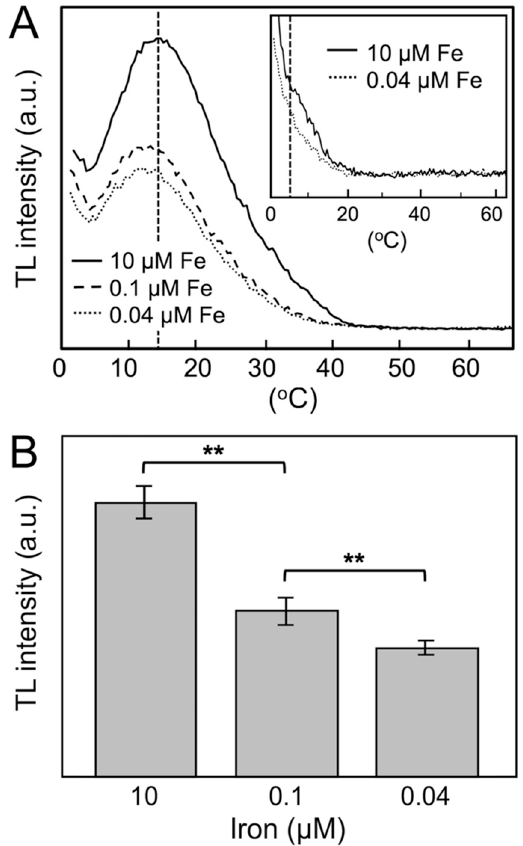
Figure 2. Effect of iron deficiency on the PSII activity of P. tricornutum cells measured by the TL technique. ( A ) Representative standard TL glow curves, obtained after excitation of P. tricornutum cells with two flashes at 1 ◦ C under different iron concentrations. Inset: TL glow curve of P. tricornutum cells in the presence of 10 or 0.04 µ M iron and 20 µ M DCMU. ( B ) Intensities obtained from the component analysis of TL curves from six independent experiments (see also Table 1). Double asterisks mark statistically different data groups ( p < 0.01). See the Methods and Materials section for more details.